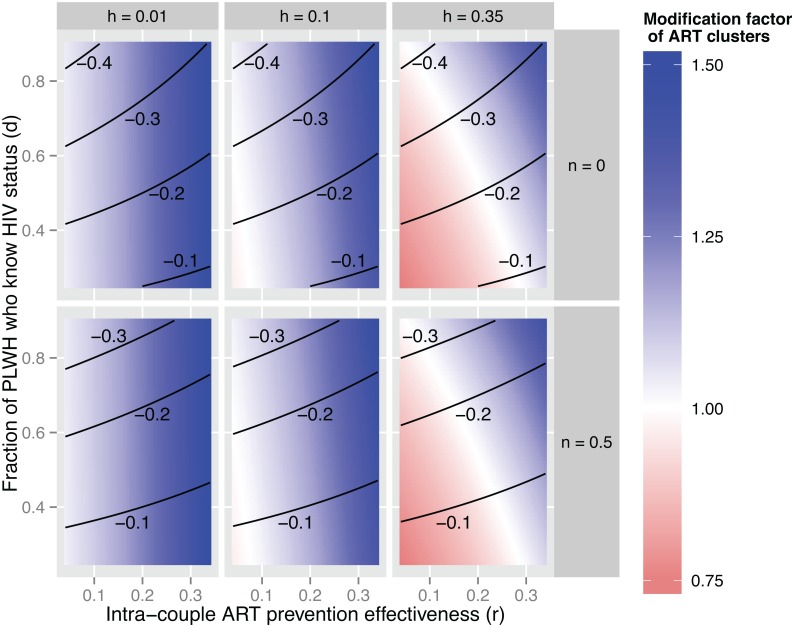
The effect of ART homophily and serosorting on the population-level impact of ART on HIV incidence, by levels of HIV prevalence (h), fraction of PLWH who are aware of their HIV status (d) and intra-couple effectiveness of ART (r).Contour lines indicate the impact of ART on HIV incidence in the absence of ART clusters (m = 0). Color-coding indicates the modification factor of ART clusters: the factor by which the ART impact on HIV incidence increases (> 1 in blue) or decreases (< 1 in red) when comparing the case of m = 1 to the case of m = 0. For example, in the darkest blue areas, the impact of ART on HIV incidence is 50% greater in the presence of perfect ART homophily (m = 1) than it would have been if networks were formed without any ART homophily (m = 0). The uptake of ART among diagnosed PLWH (a) was fixed at 50% in all model scenarios shown.